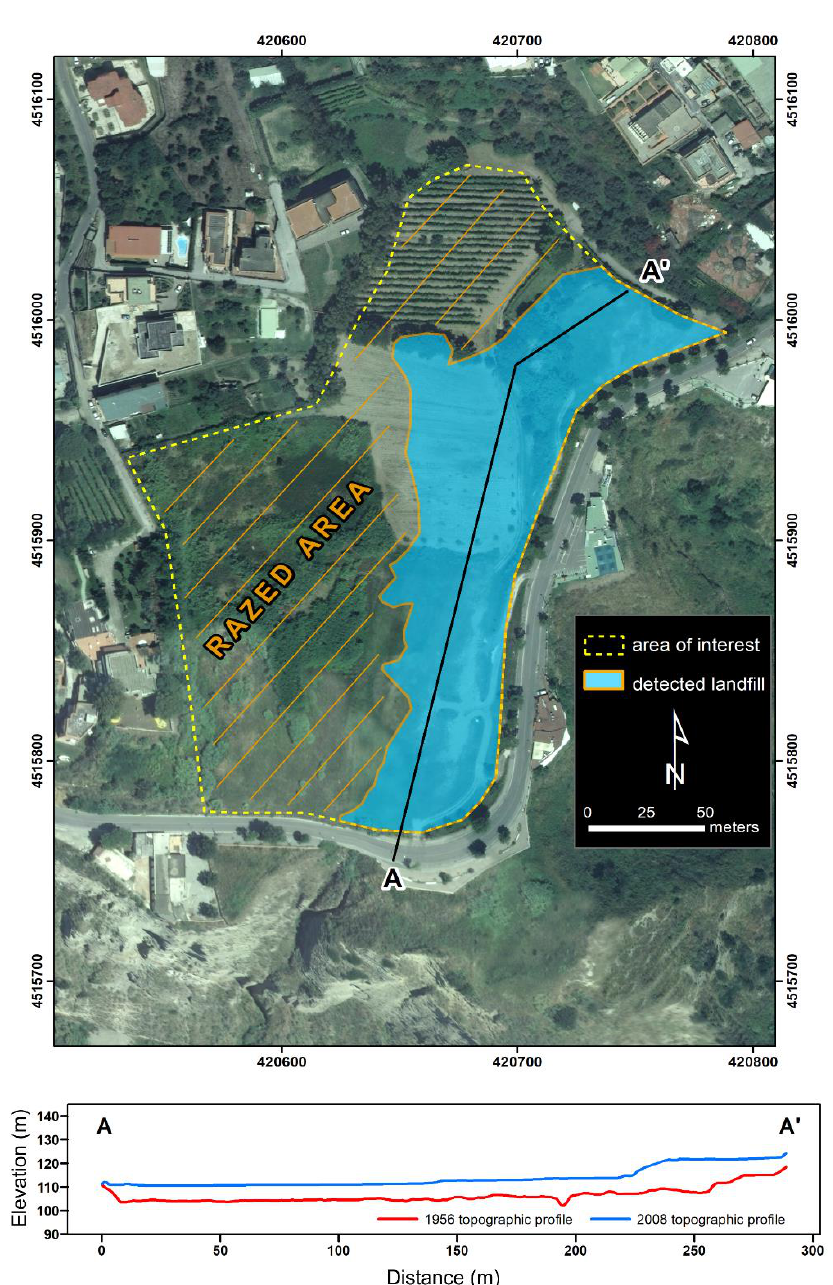
Figure 7. Map representing the areal extent of the detected landfill, and two cross-sections delimiting deposits laying between the 1956 and 2008 ground surfaces. Orthophoto in background is related to the year 2014 (Courtesy of Regione